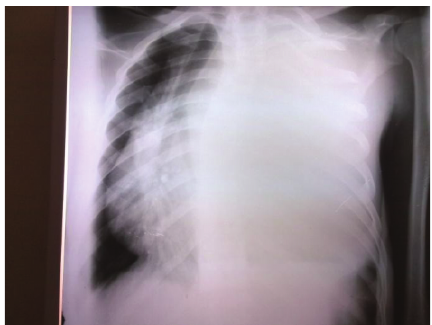
Figure 2: Chest radiograph showing homogenous opacification of the entire left hemithorax with marked mediastinal shift to the right.